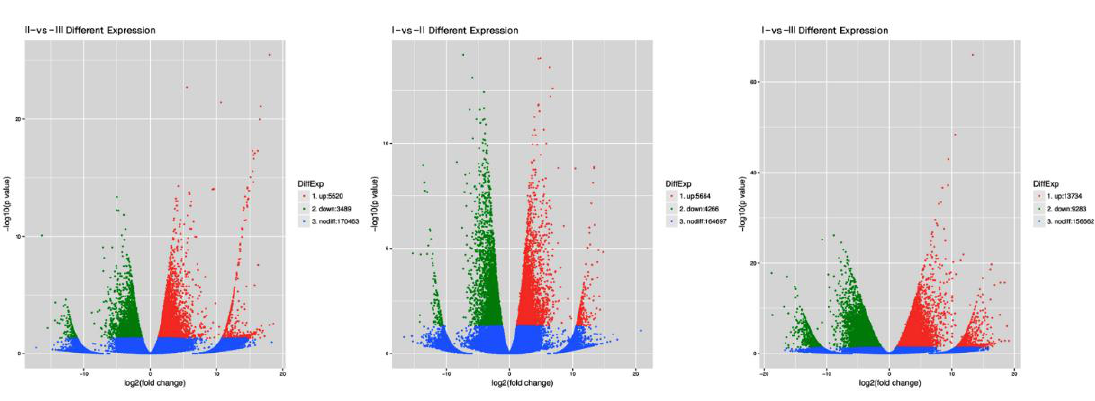
Figure 3. Volcano map of differentially expressed unigenes in the II-VS-III, I-VS-II, and I-VS-III comparisons. I, II, and III represent the three sampling dates: 70 DAF, 82 DAF, and 94 DAF.